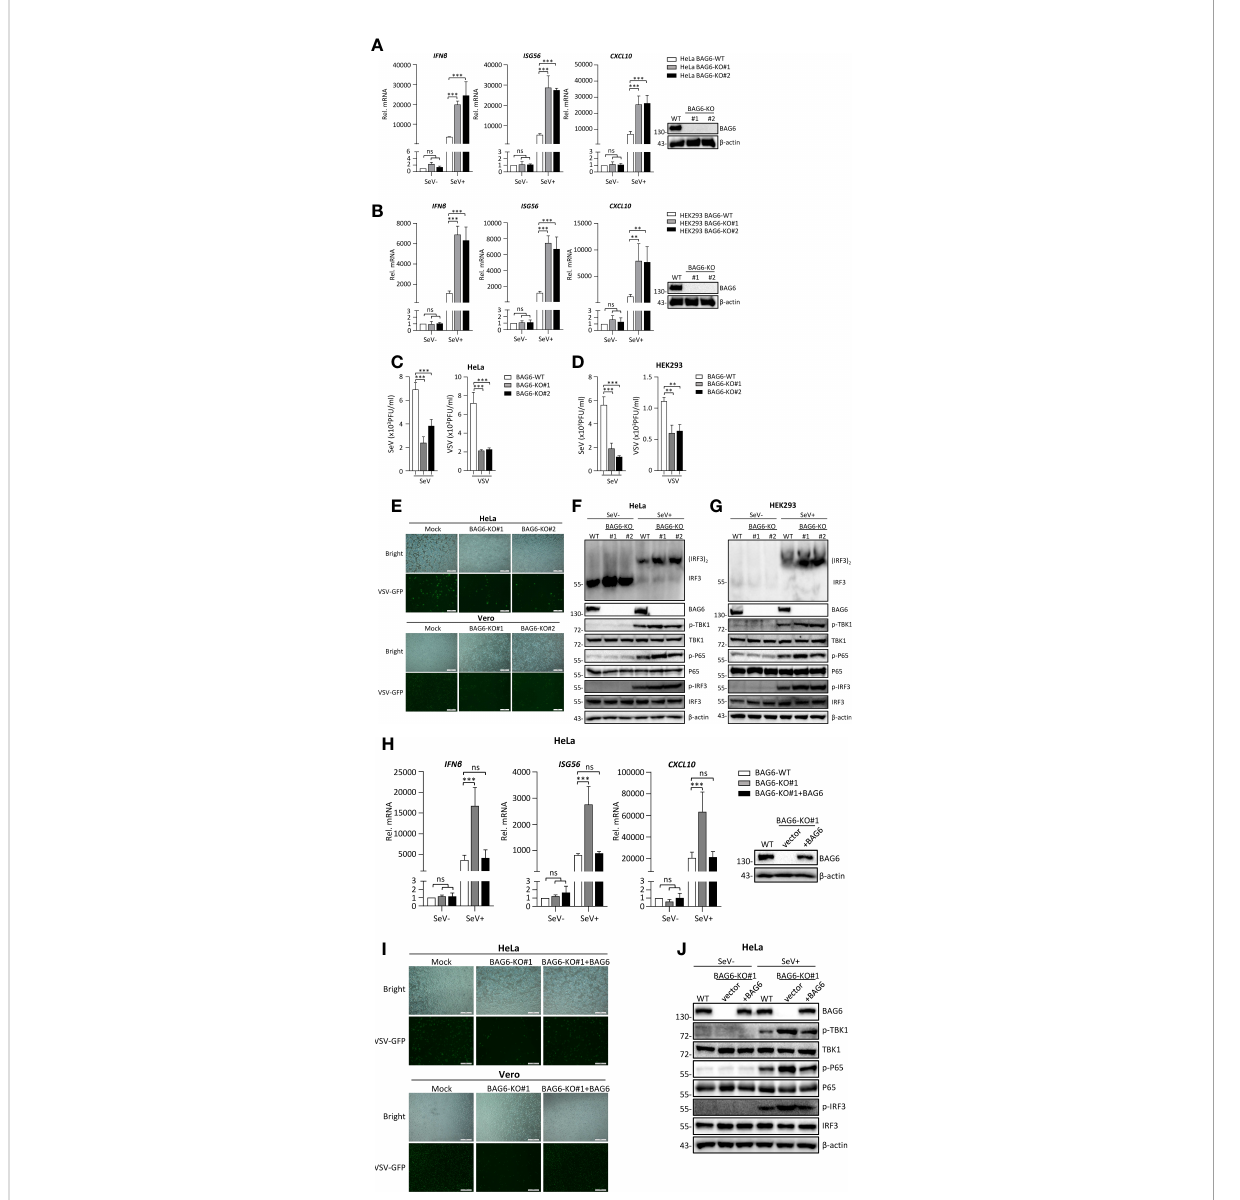
FIGURE 3 BAG6-de fi ciency signi fi cantly increases the transcription and activation of antiviral genes in HeLa and HEK 293 cells. (A) BAG6-de fi ciency enhances the transcription of downstream antiviral genes in HeLa cells. BAG6-de fi cient HeLa cells were left uninfected or infected with SeV (MOI = 1) for 8 h before qPCR analysis. (B) BAG6-de fi ciency enhances the transcription of downstream antiviral genes in HEK 293 cells. BAG6- de fi cient HEK 293 cells were left uninfected or infected with SeV (MOI = 1) for 8 h before qPCR analysis. (C) BAG6-de fi ciency inhibits the replication of SeV and VSV in HeLa cells. BAG6-de fi ciency HeLa cells were infected with SeV or VSV (MOI = 0.1) for twenty hours. The supernatants were collected for plaque assays to determine the viral titer. (D) BAG6-de fi ciency inhibits the replication of SeV and VSV in HEK 293 cells. BAG6-de fi ciency HEK 293 cells were infected with SeV or VSV (MOI = 0.1) for twenty hours. The supernatants were collected for plaque assays to determine the viral titer. (E) Effects of BAG6 de fi ciency on VSV-GFP replication. BAG6-de fi cient HeLa and control cells were infected with VSV-GFP (MOI = 0.1). The cells were viewed with Fluorescence Microscope after 16 h, and the supernatants were collected to infect Vero cells to determine the VSV-GFP replication. (F, G) BAG6 de fi ciency enhances RNA virus-induced dimerization of IRF3 and phosphorylation of TBK1, P65, and IRF3. BAG6-de fi cient HeLa and HEK 293 cells were uninfected or infected with SeV (MOI = 1) for 8 h before immunoblotting. (H) Reconstitution of BAG6 in BAG6-de fi cient HeLa cells suppresses virus-mediated innate immune responses. HeLa-BAG6- KO cells were transfected with control or BAG6 plasmids for 36 h. Cells then were left uninfected or infected with SeV (MOI = 1) for 8 h before qPCR analysis. (I) Reconstitution of BAG6 in BAG6-de fi cient HeLa cells enhances the replication of the virus. Similar to (E) , HeLa-BAG6-KO cells were transfected with control or BAG6 plasmids for 36 h, and cells then were infected with VSV-GFP (MOI = 0.1). (J) The experimental treatment was the same as (H) before immunoblotting. (** p < 0.01; *** p < 0.001; ns, no signi fi cant difference). The size bar represents 500 m